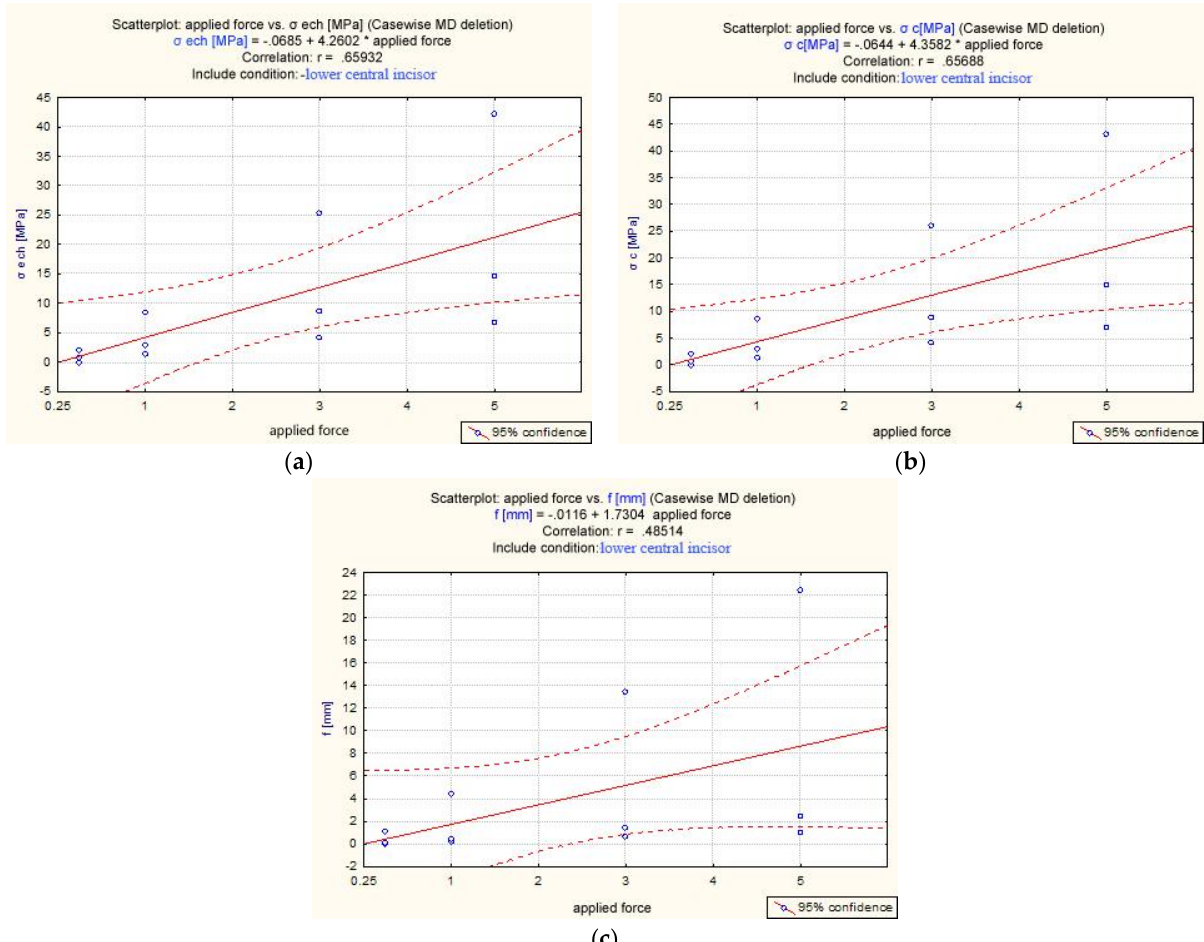
Figure 13. Regression line for the correlation of ( a ) σ ech, ( b ) σ c, and ( c ) f vs. applied force.